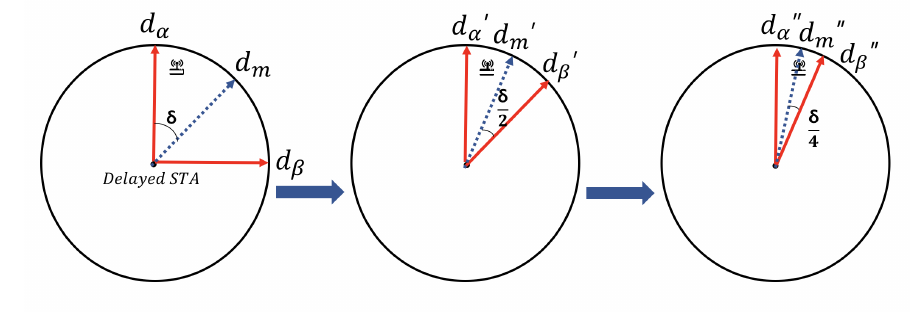
( (cid:104) d α , d (cid:105) , BSR ) in Algorithm β HR